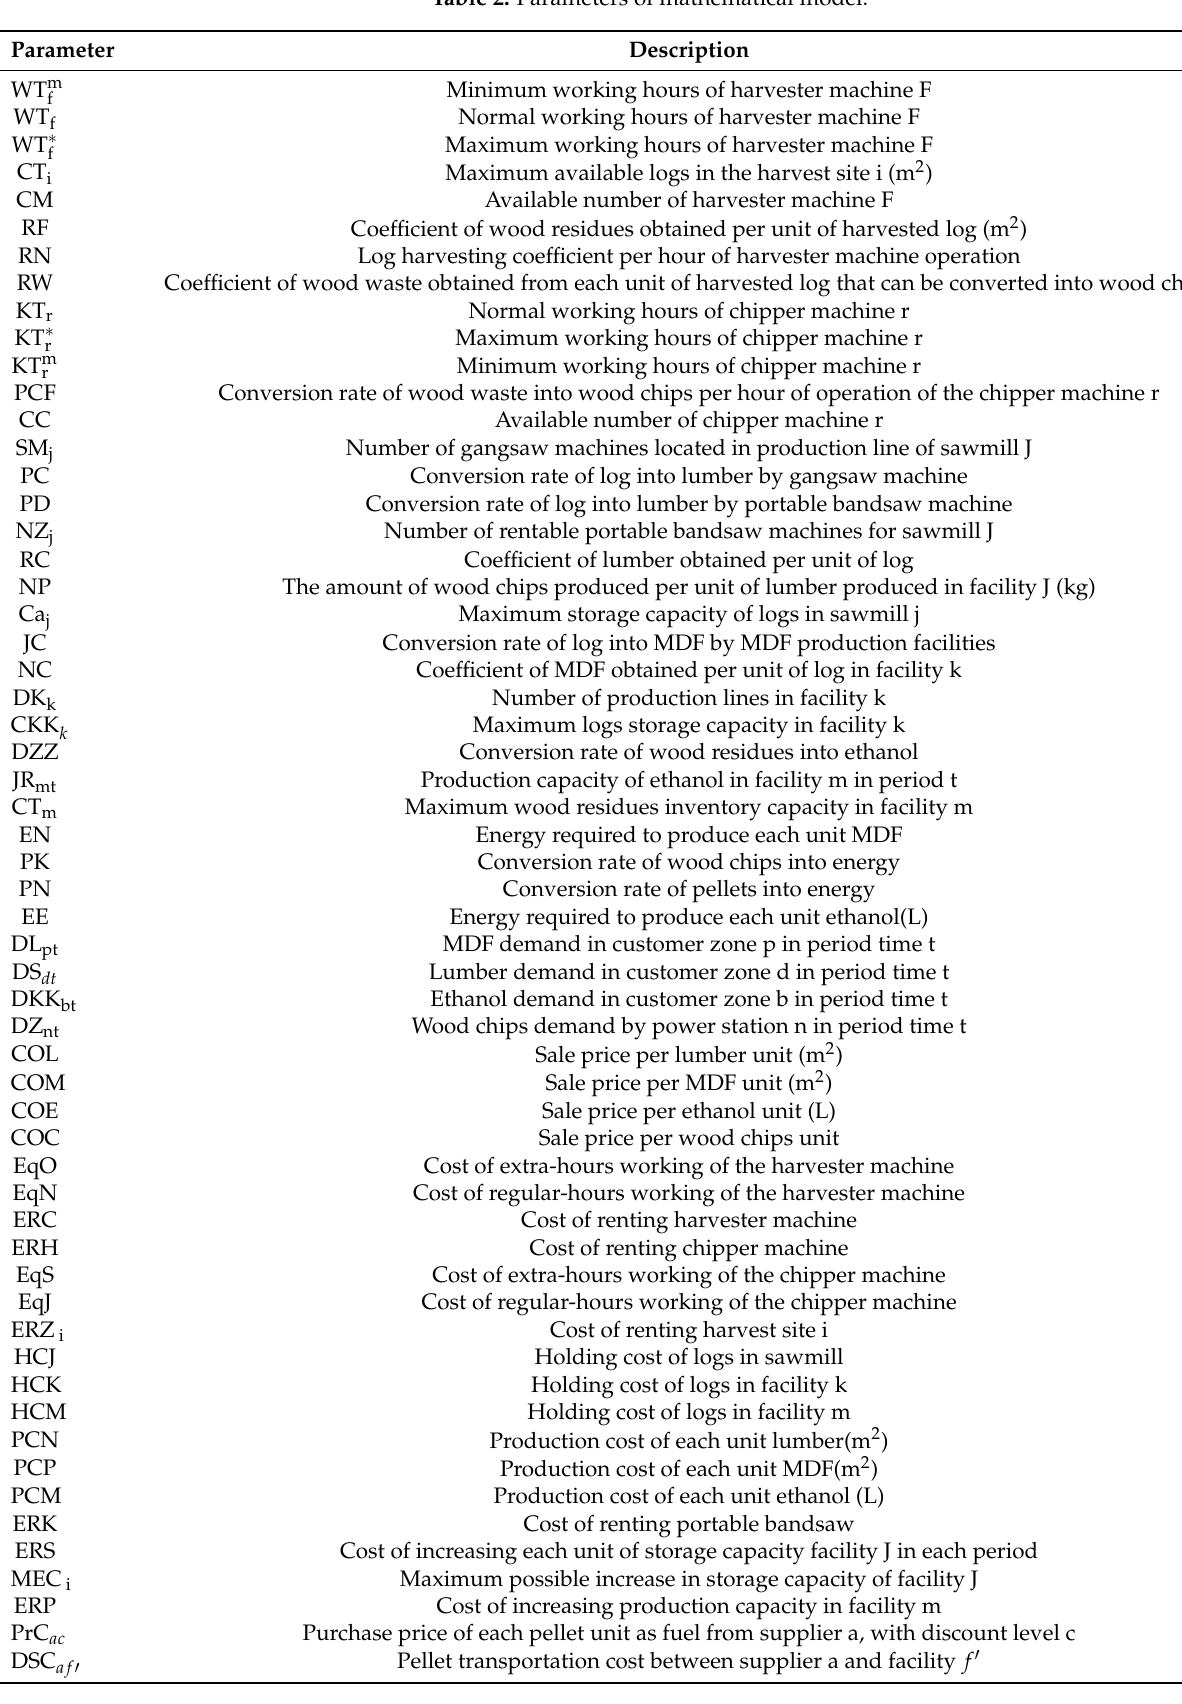
Table 2. Parameters of mathematical